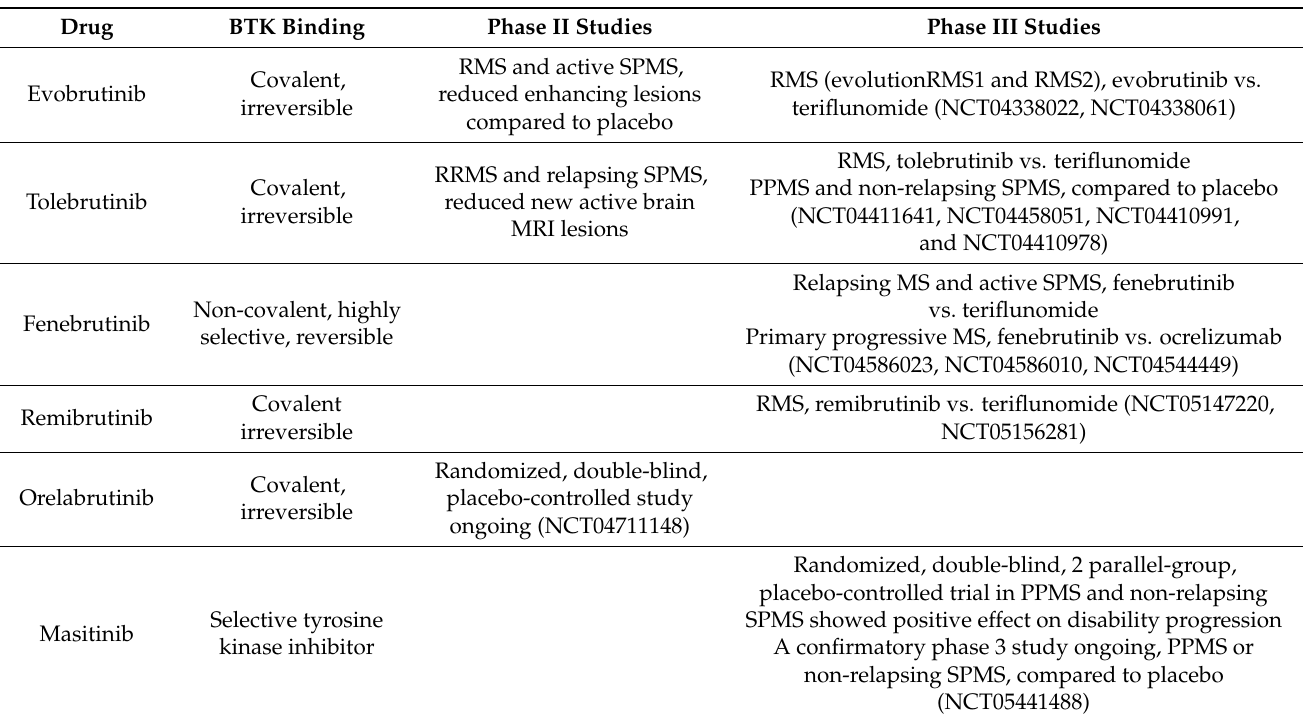
Table 1. Phase 2 and 3 Clinical Trials of BTK and other TK inhibitors in MS